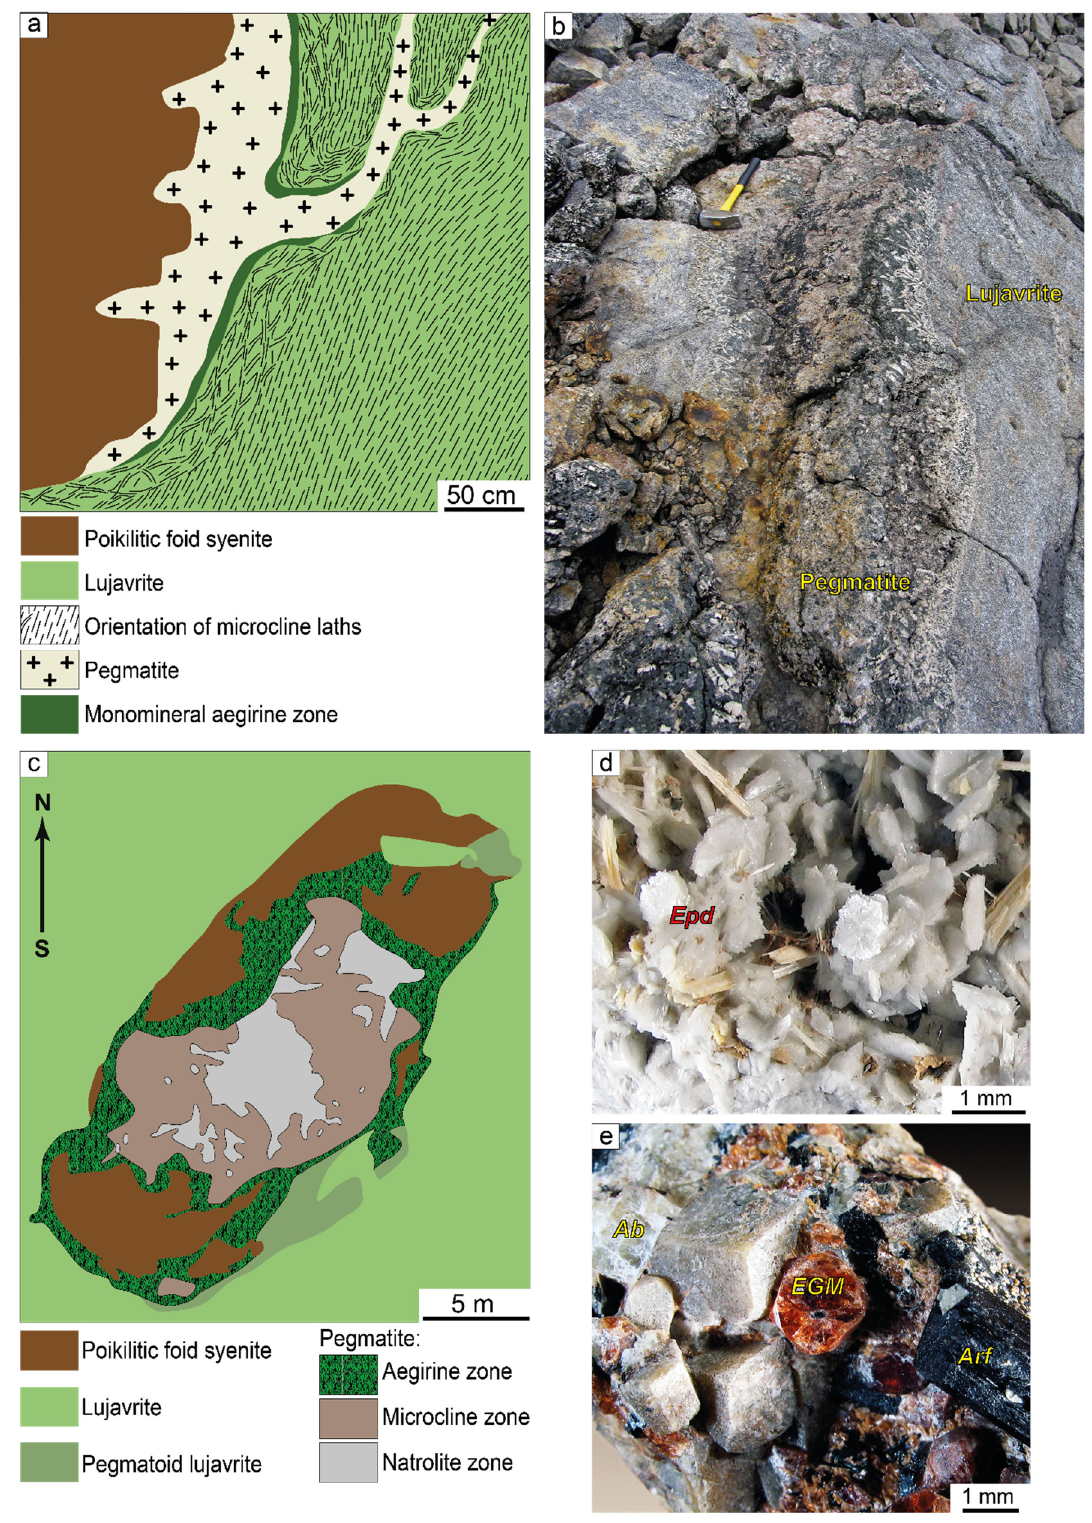
Figure 2. ( a ) Scheme of pegmatite apophysis in lujavrite, adapted from [27]. Lujavrite lacks a trachytoid texture near the contact. ( b ) Pegmatite apophysis in lujavrite on Sengischorr Mountain. Photo by Gregory Ivanyuk. ( c ) Scheme of the pegmatite No. 47 (Lepkhe-Nel’m Mountain), adapted from [28]. In this example, the volume of poikilitic foid syenite is small compared with the volume of pegmatite, but this ratio can vary greatly. ( d ) Epididymite (Epd) crystals from pegmatite No. 47. ( e ) Eudialyte (EGM), arfvedsonite (Arf), and albite (Ab) crystals pegmatite No. 47. Photo by Gregory Ivanyuk.